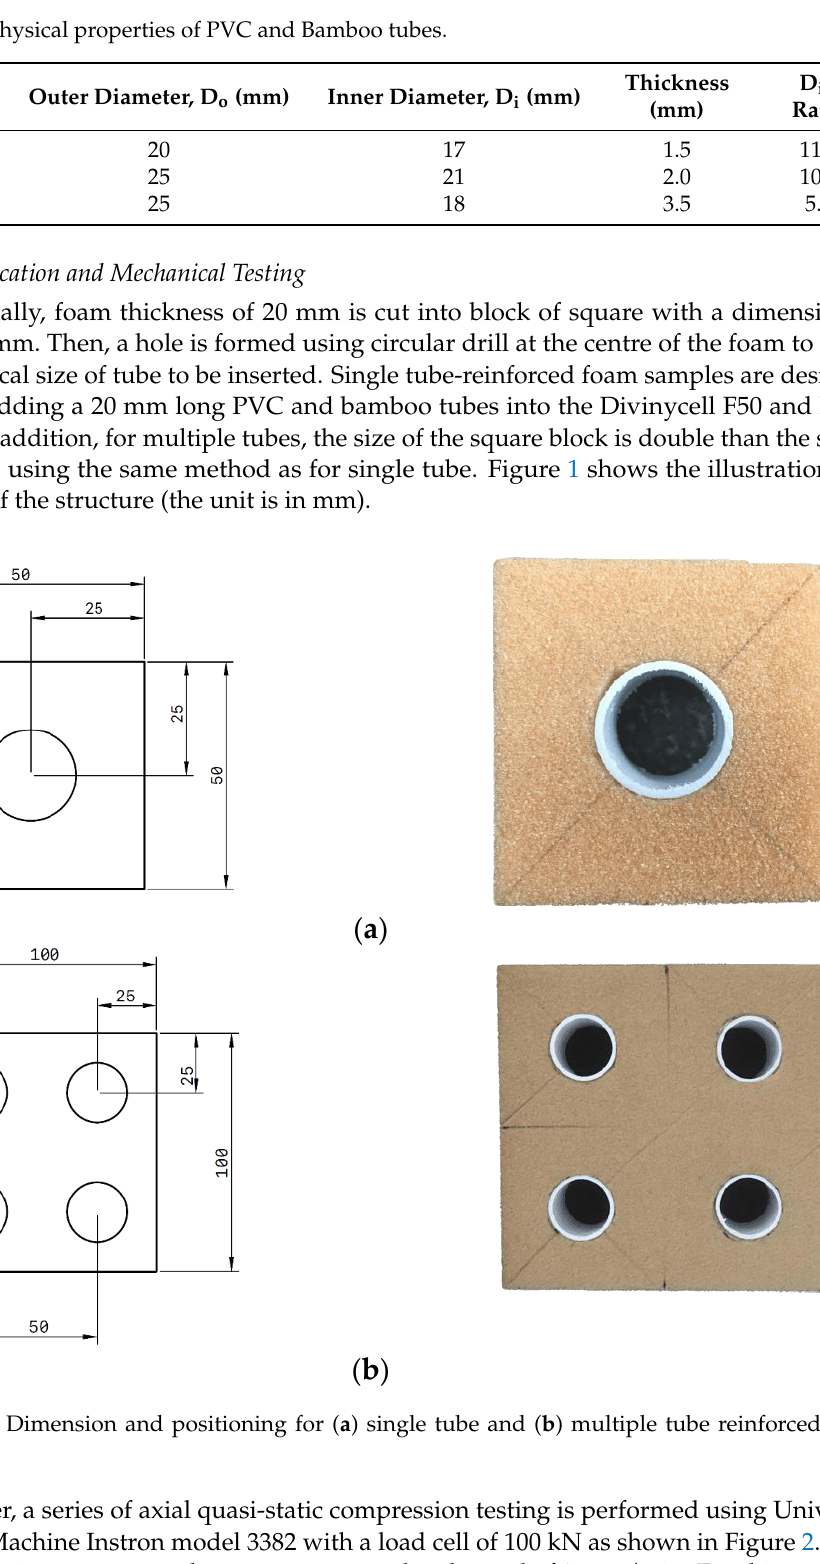
Table 1. Physical properties of PVC and Bamboo tubes.